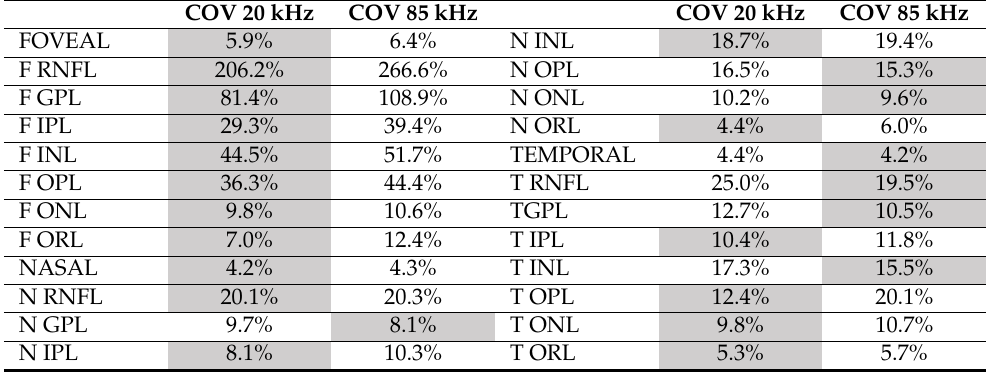
Table 2. Coefficients of variation (COV) for each layer measure with 20 kHz A-scan rate OCT and with 85 kHz A-scan rate OCT. The values labeled in grey are the lower values for each layer (F = foveal, N = nasal, T = temporal; RNFL: retinal nerve fiber layer; GCL: ganglion cell layer; IPL: inner plexiform layer; INL: inner nuclear layer; OPL: outer plexiform layer; ONL: outer nuclear layer; ORL: outer retinal